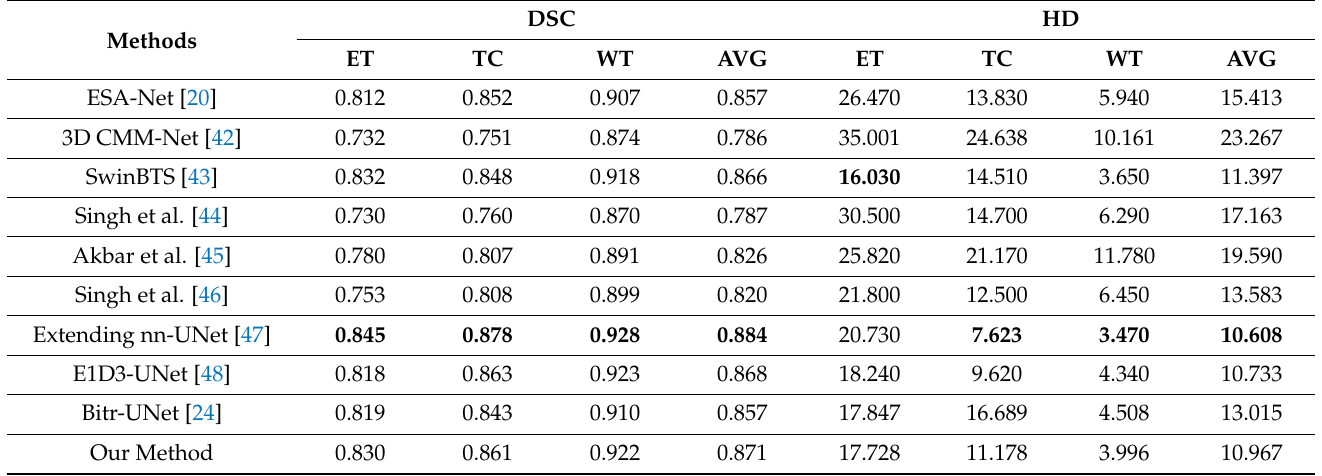
Table 4. Objective performance comparison with the state-of-the-art methods on the BraTS2021 validation dataset, in terms of their DSC and HD values. (Bold font indicates best